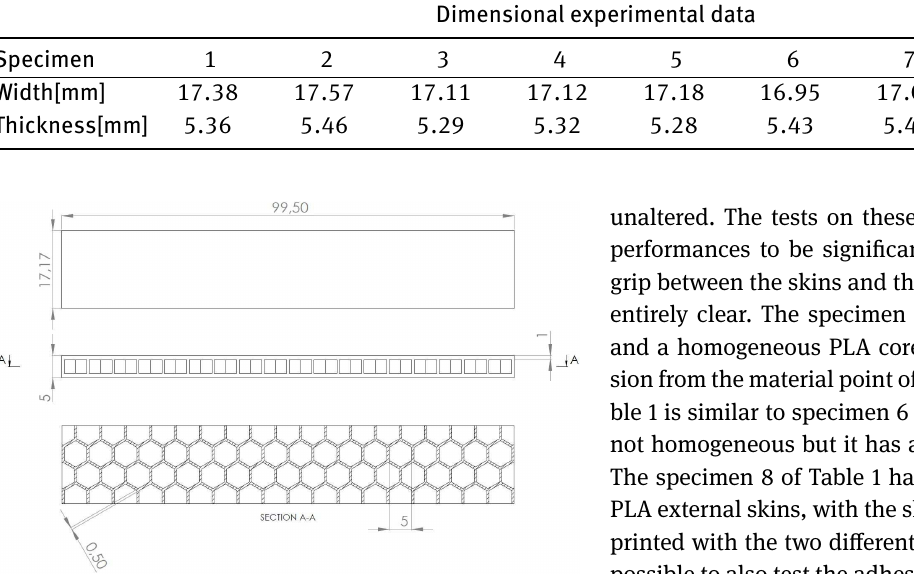
Dimensional experimental data